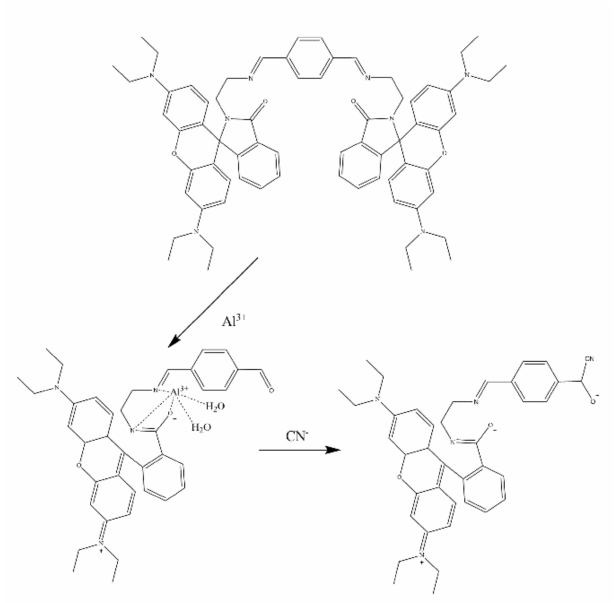
Figure 58. The possible binding mechanism of the prepared sensor (Table 4, No. 9) for Al 3+ and CN − [114].